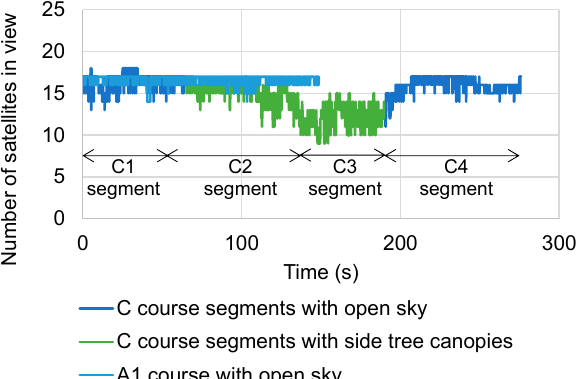
Figure 7. An example of the variation of the number of satellites in view during the measurements of RTK-TTRF.